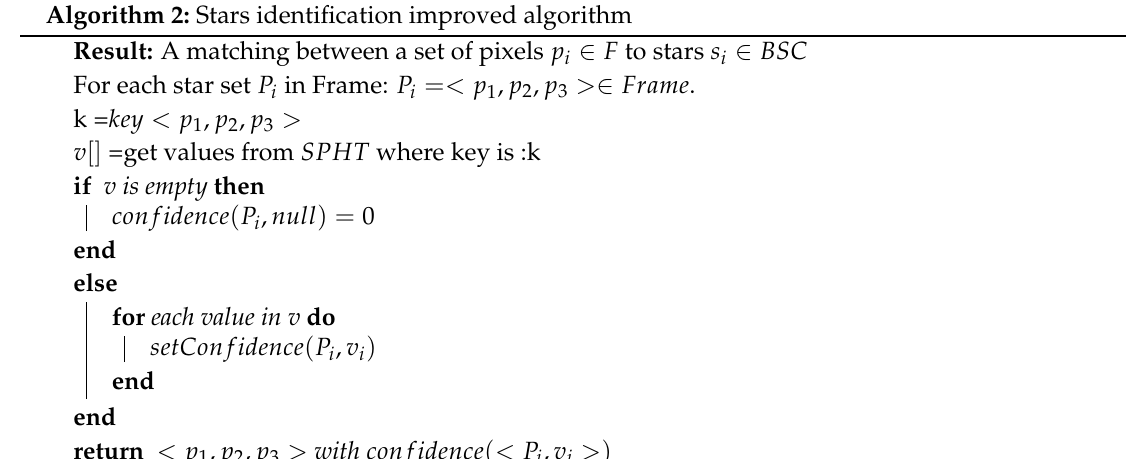
Algorithm 2: Stars identification improved